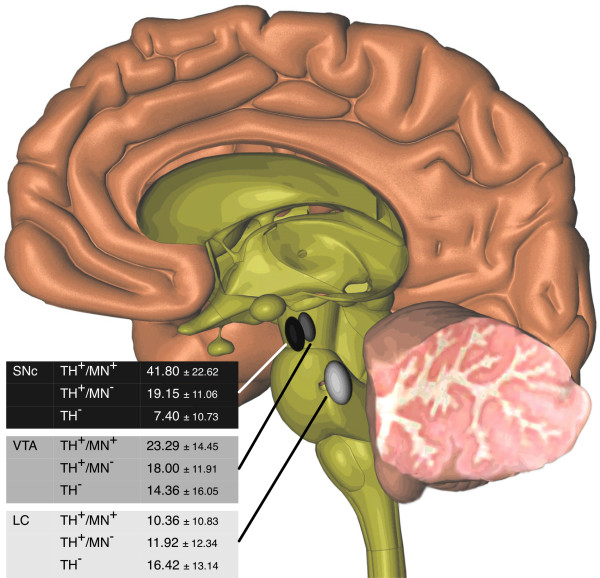
Differential vulnerability of catecholaminergic brainstem neurons in healthy aged controls. 3-D model of the brain showing location of brainstem nuclei and ΔmtDNA levels of pigmented (TH+/NM+) and non-pigmented (TH+/NM-) catecholaminergic neurons, as well as non-catecholaminergic (TH-) neurons in these nuclei. Values represent mean ± standard deviation of data collected from healthy aged controls (78.7 ± 9.0 years). Highest deletion levels are seen in pigmented neurons of the SNc (black). VTA neurons show intermediate ΔmtDNA levels (grey) and LC neurons lowest (light grey). PD pathology is deviating from this pattern, as SNc and LC show heavy degeneration whereas the VTA is relatively spared.